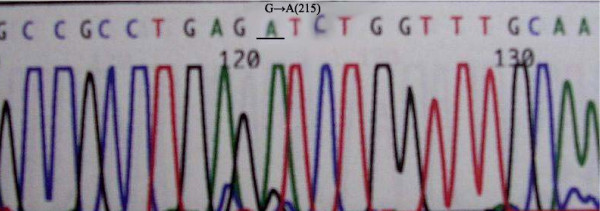
Representative transition of p53 exon 6 (G: C/A: T) found in cholangiocarcinoma.